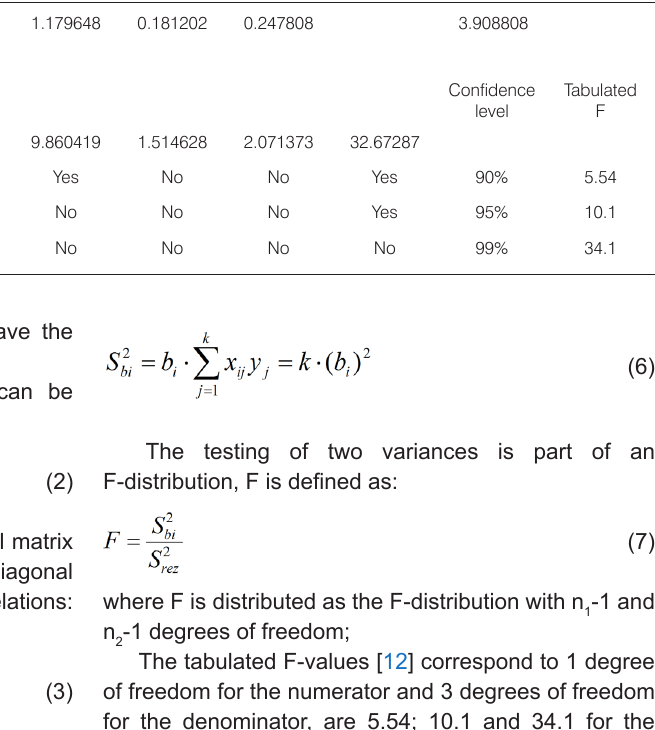
Table 4. Variances and F factors associated to each term of the polynomial model. S 2